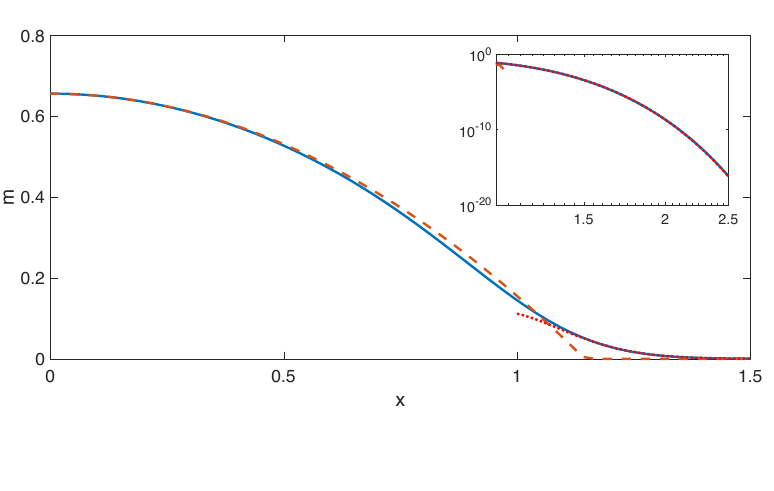
Figure 2: Computational solution of the Gross-Pitaevskii equation (full), Thomas- Fermi approximation (dashed) and semi-classical uniform approximation (dot). The inset shows the same curves in Log-Linear plot focusing on the tail of the distribution. Parameters for this figure are g = − 2, σ = 0.4, µ = 1, U ( d =